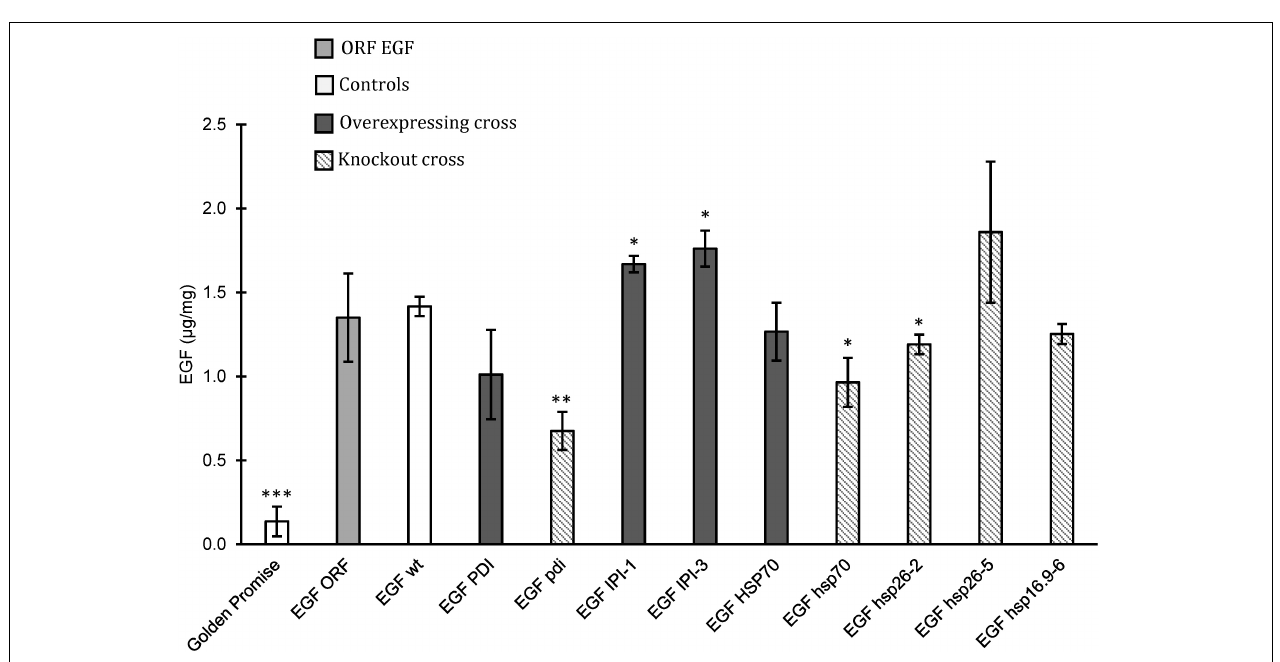
FIGURE 4 | Mouse leukemia inhibitory factor (mLIF) concentration based on ELISA assay in mature grain flour. Golden Promise (white) was used as a negative control. ORF mLIF was used as positive control (light gray). Crossed plants with overexpression (dark gray), crossed plants with knockout mutation (diagonal) and crossed plants with no mutation (dotted). Plants were grown in growth chamber or greenhouse. Error bars represents the standard error and significant differences by Student’s t -test. ∗ p < 0.05, ∗∗ p < 0.01 and ∗∗∗ p < 0.001.